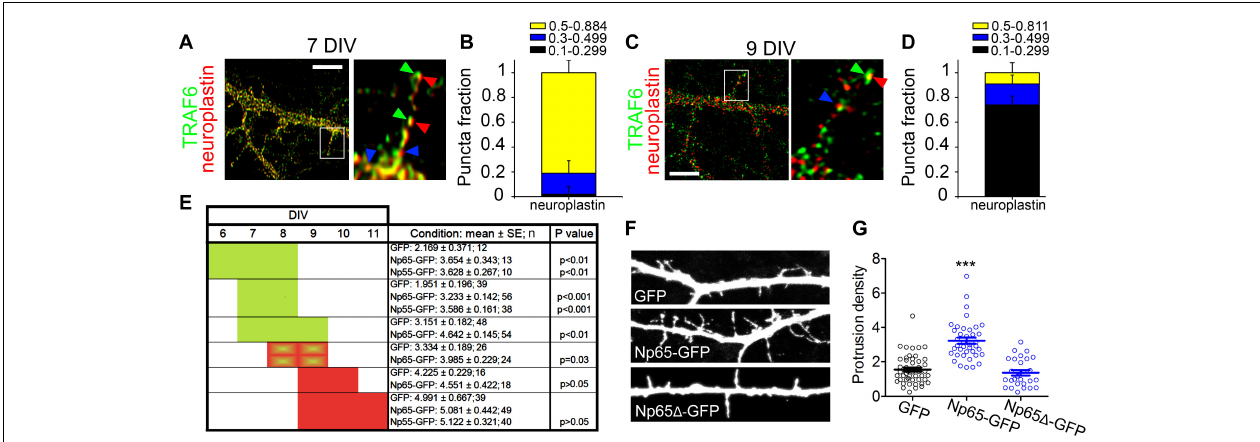
FIGURE 4 | Permissive time period for protrusion induction by neuroplastin and TRAF6. (A,D) To avoid interference with the intracellular interaction of TRAF6 with the tail of neuroplastin, methanol-fixed rat hippocampal neurons at 7 and 9 DIV were stained with a sheep pan-neuroplastin antibody recognizing the common extracellular Ig2-like domain of Np55 and Np65 and with an rabbit anti-TRAF6 antibody recognizing the amino acids 1–274 located at the intracellular N-terminal of TRAF6. These primary antibodies were followed by proper fluorophore-tagged secondary antibodies, mounted, and imaged using a 100x objective and confocal microscopy. Images were deconvolved to eliminate optic aberrations and improve resolution (see section “Materials and Methods”). (A,C) Confocal pictures and digital magnifications of dendritic protrusions are shown. Green arrows show co-localized TRAF6 spots, red arrows point to co-localized neuroplastin spots, and blue arrows show neuroplastin spots with lower co-localization degree. Scale bars = 5 µ m. (B,D) Quantification of the fractions of neuroplastin spots co-localized with TRAF6 spots was performed using single z-planes. The degree of co-localization of neuroplastin was scored as high (Pearson’s coefficient from 0.5 to 0.884